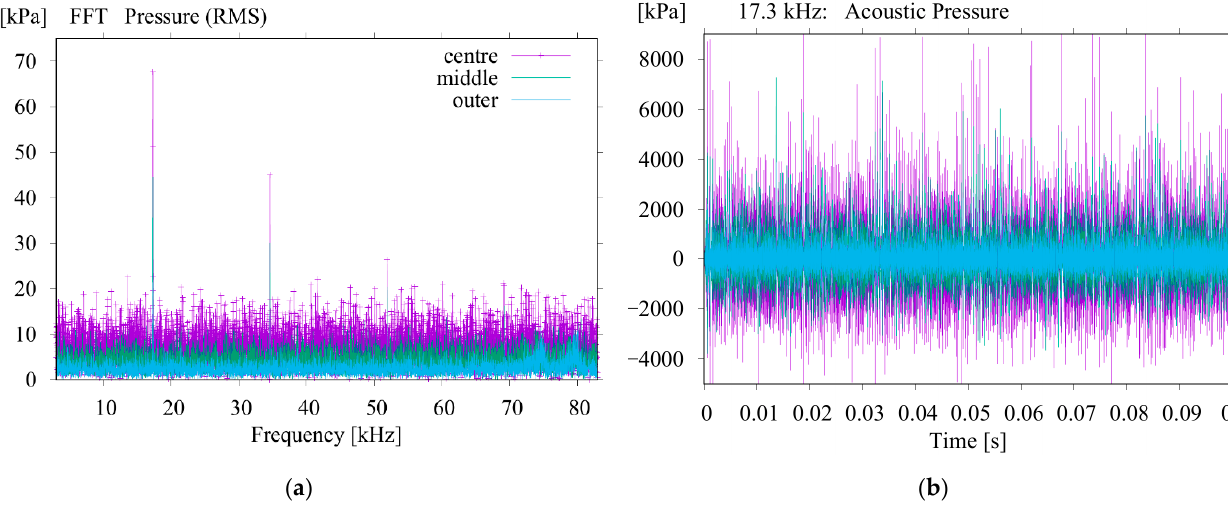
Figure 3. ( a ) FFT frequency response from a Caflisch cavitation model with the sonotrode positioned in the launder, and ( b ) the time series data at three nodal locations.